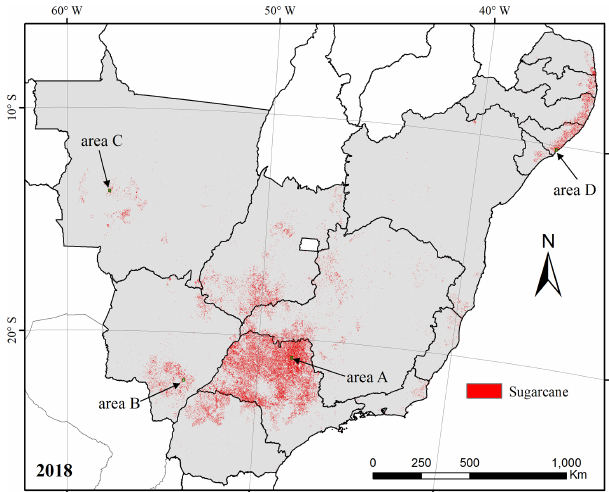
Figure 8. Sugarcane harvest map for the 14 studied states in Brazil in 2018. The administrative boundary data were obtained from the